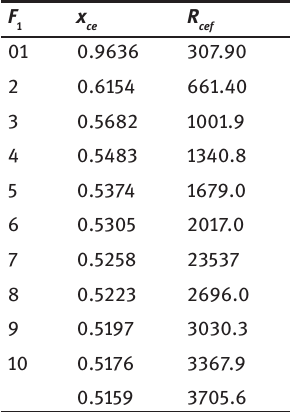
Table 1: The variation in the fluid-based critical thermal Rayleigh number R with the couple-stress parameter F cef and S = 100. f